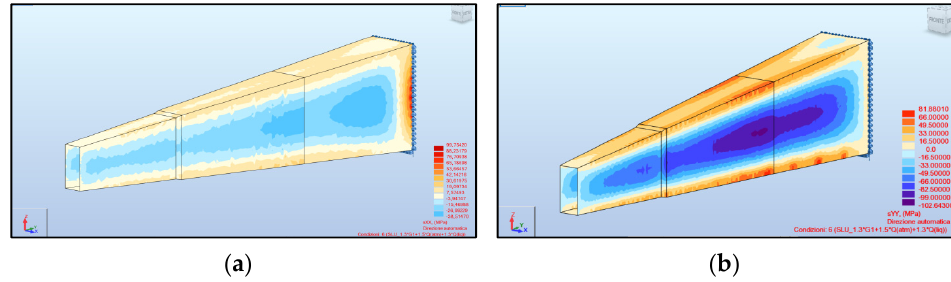
Figure 11. External steel sheet stress path: ( a ) UC σ x; ( b ) UC σ y.